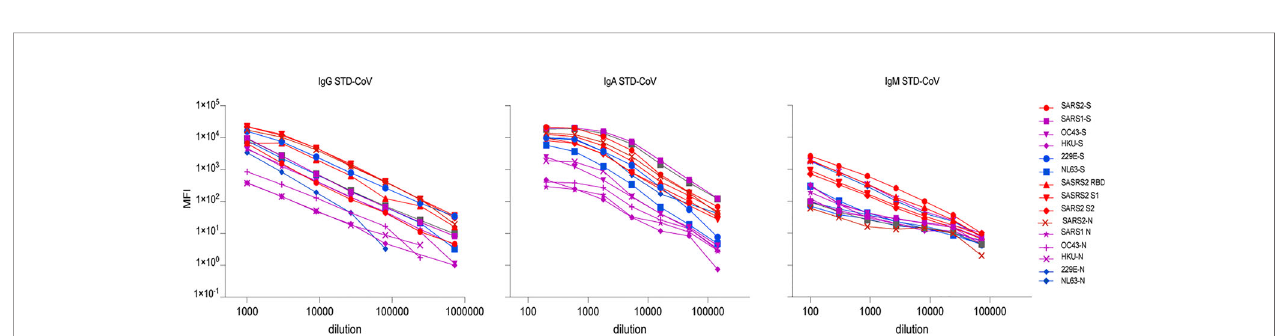
FIGURE 4 | The standard curves of IgG, IgA, and IgM antibody of the individual spike (S) and nucleocapsid (N) proteins of control positive serum of human coronaviruses (STD-CoV). A polyclonal coronavirus standard (STD-CoV) anti-serum of IgG, IgA, and IgM used was a mixture of four anti-SARSCoV-2 positive sera, which contained high antibodies against the SARS-CoV-2 and some of seasonal human coronaviruses. Each spot represents the mean concentration of antibody against one strain of HCoVs from duplicate wells.